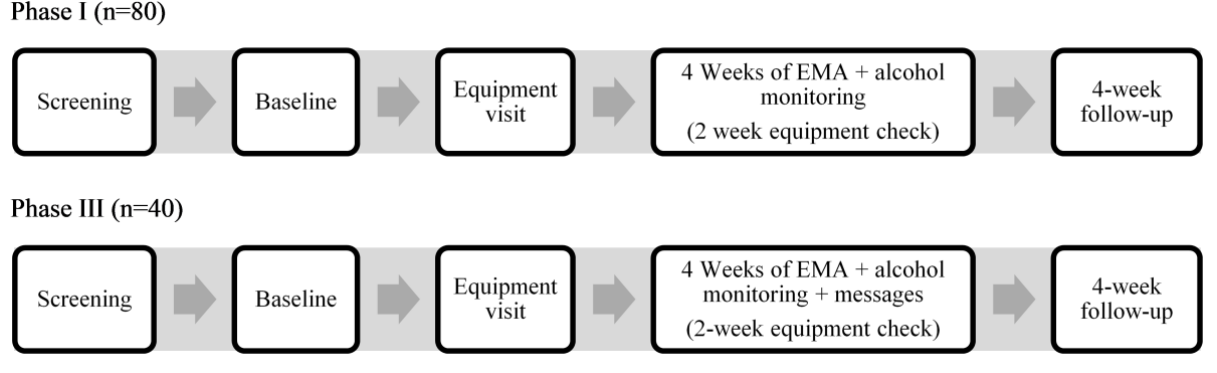
Figure 1. Phase I and III flowcharts. EMA: ecological momentary assessment.